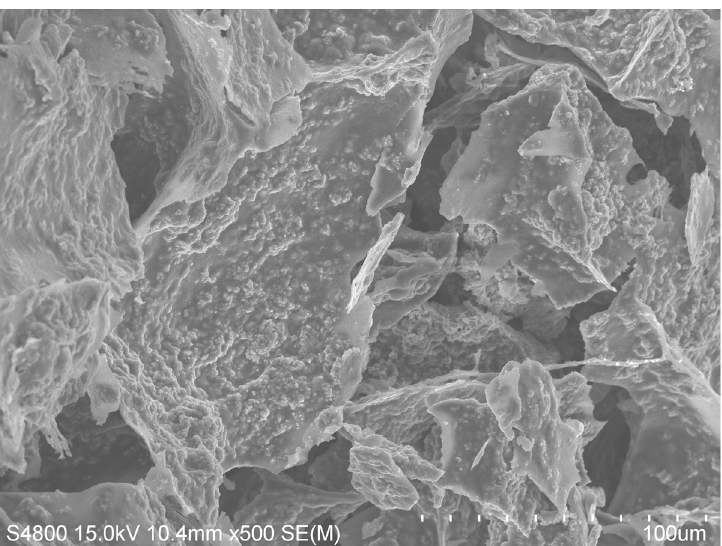
Fig 1. Micrographs of nHA-CS. The nHA-CS scaffold exhibited a three-dimensional porous structure in which the nHA particles were evenly distributed throughout the pore surface (figure magnification 500×).